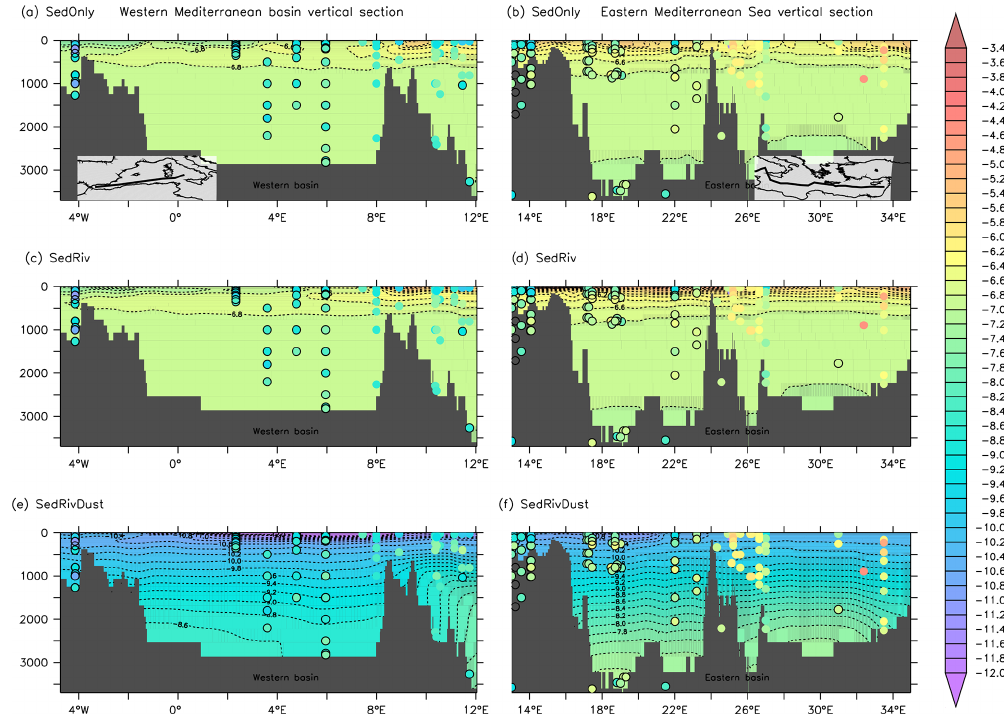
Figure 7. Same as Fig. 4 but for ε Nd (in ε Nd